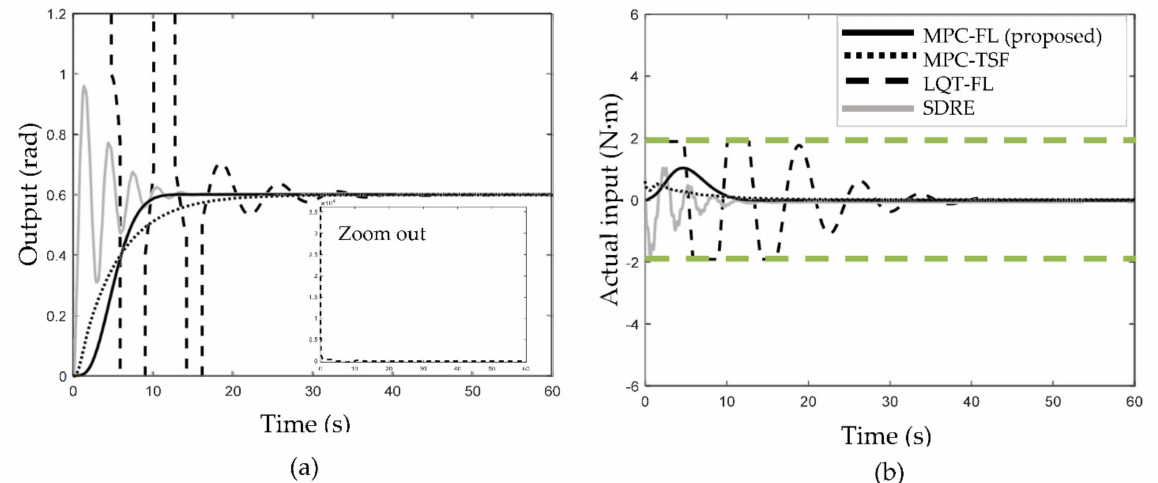
Figure 5. Flexible-joint mechanism by applying the four control schemes with input constraints ± 1.9 N · m: ( a ) output responses; ( b ) input